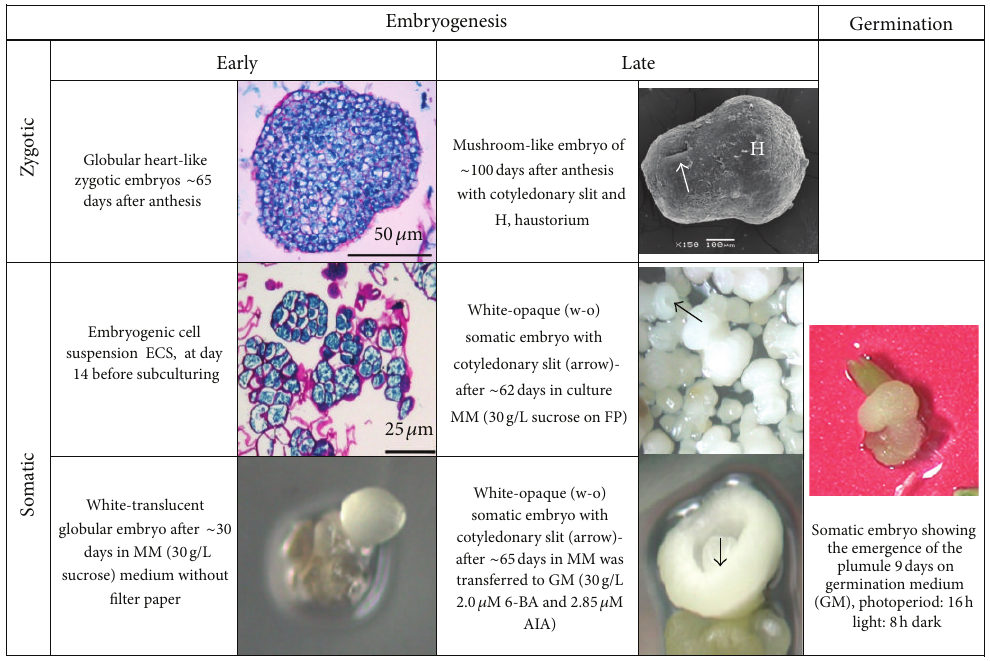
Figure 2: Different stages of zygotic and somatic embryogenesis of M. acuminata ssp. malaccensis plant material used for cDNA-AFLP analysis.